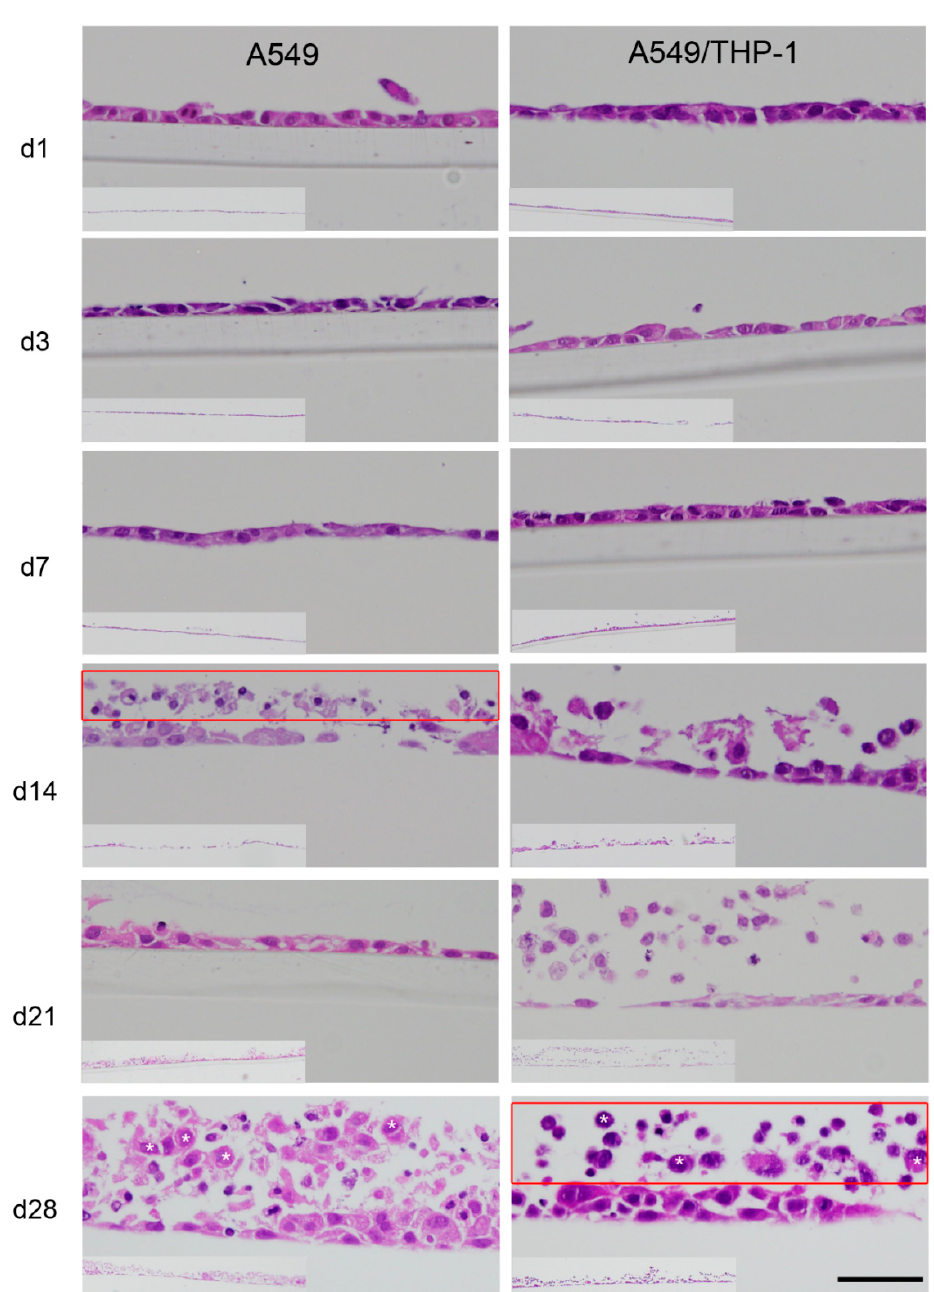
Figure 4. Radial section of A549 mono and A549/THP-1 co-cultures stained with hemalaun. After 14 days, dead cells arise on top of the monolayer. At 28 days, pronounced shedding of dead cells is seen. Inserts with lower magnification show regional variations. The scale bar indicates 50 µm in the higher and 500 µm in the lower magnifications (inserts).